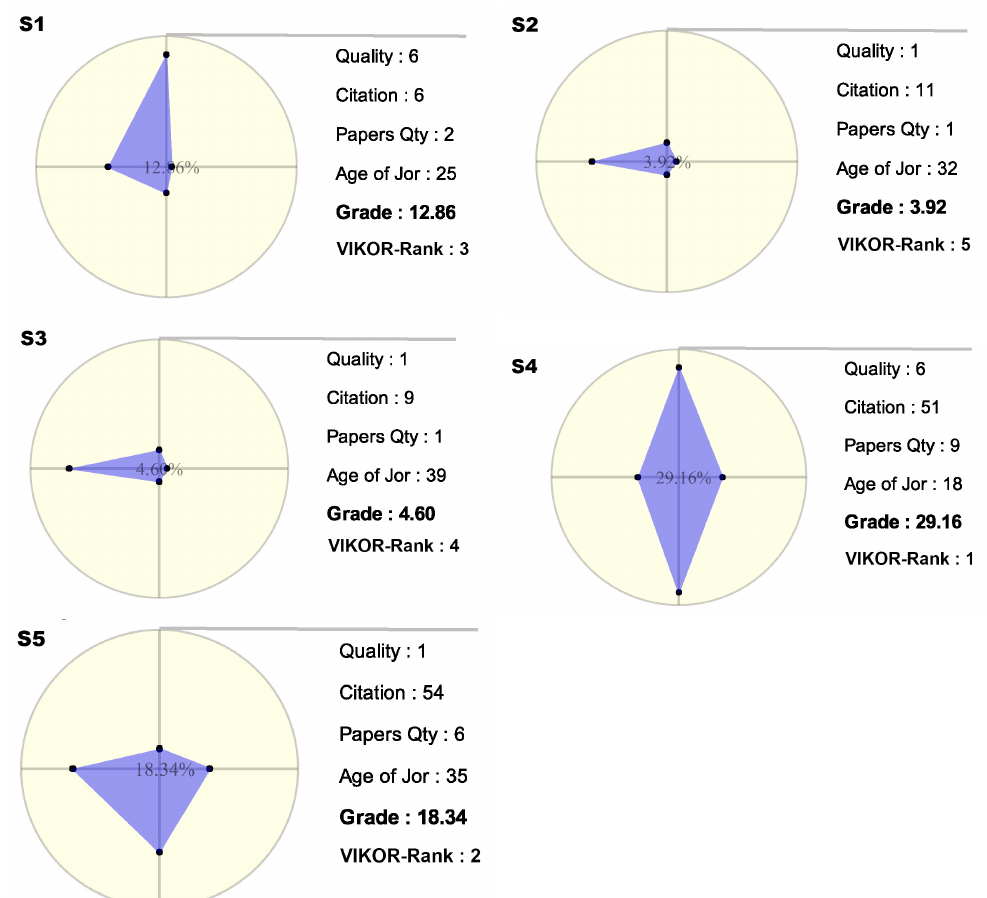
Figure 17. The radar graphs of alternatives which are used as sample.